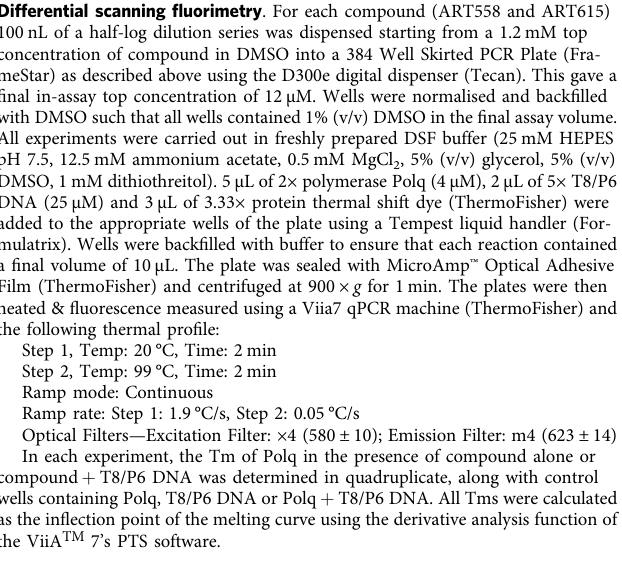
Fig. 4 DNA damage-related phenotypes in Brca1 Δ 11 ;Trp53bp1 ‒ / ‒ cells exposed to ART558. a γ H2AX foci per nucleus in Brca1 Δ 11 , Trp53bp1 ‒ / ‒ or Brca1 Δ 11